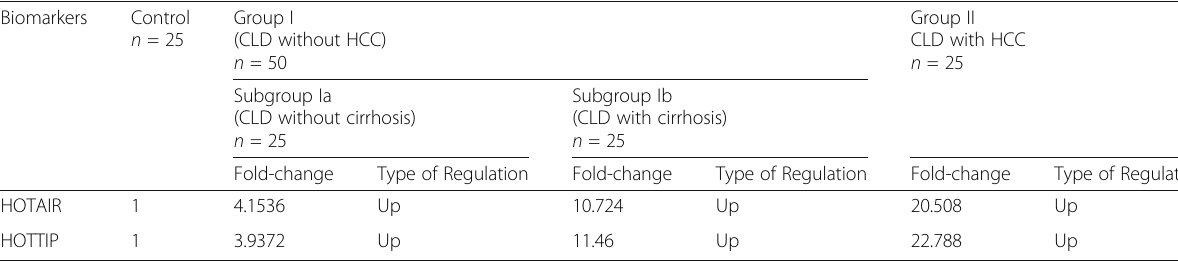
Table 3 Biomarkers fold change in the studied groups